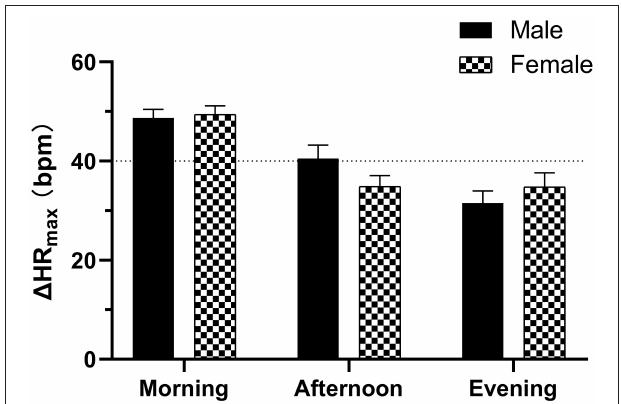
FIGURE 2 | Diurnal variability of the maximum HR increment ( 1 HRmax) in the standing tests between males and females with POTS. Data are mean ± 95%